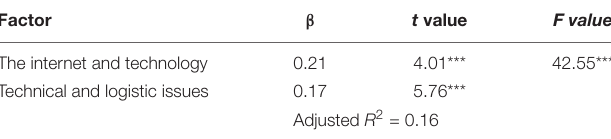
TABLE 4 | Linear regression results.